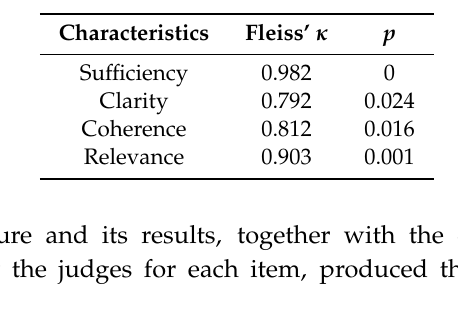
Table 6. Fleiss’ κ coe ffi cient and statistical significance of the characteristics of the original instrument.